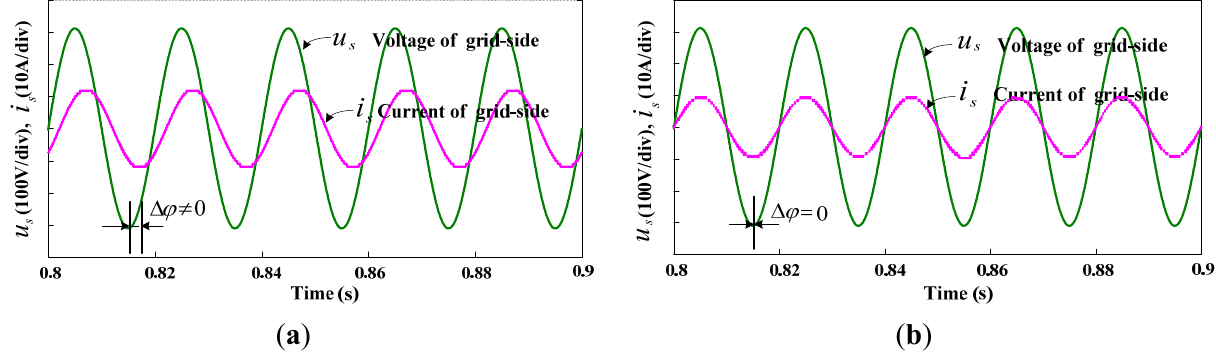
Figure 13. The voltage and current waveforms of grid-side in reactive compensation mode. ( a ) Before compensation; ( b ) After